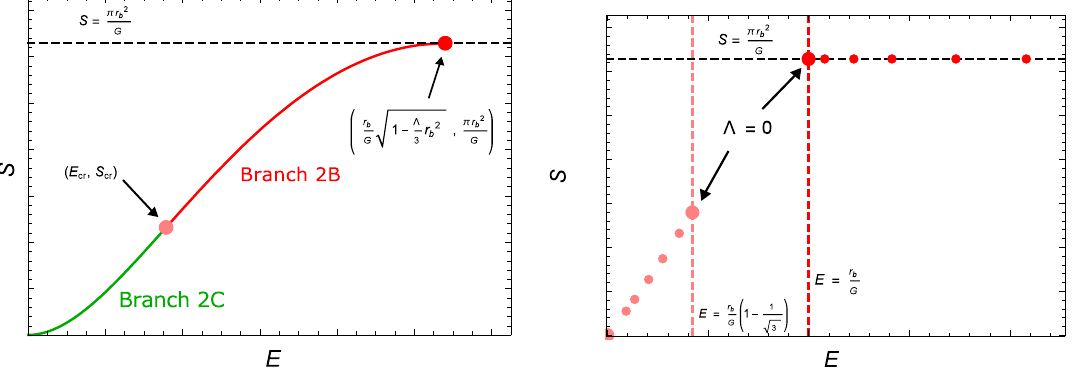
Figure 4 . ( Left ) Qualitative behavior of entropy as a function of energy. The critical point and the maximum entropy point are marked. The energy and entropy at the critical point are given by 2 (see the main text). The maximal energy and entropy are E cr = E cr ( r b , Λ) and S cr = πr H,cr ( r b , Λ) G q 1 − Λ and πr 2 b . ( Right ) Behaviors of critical point and maximum entropy point against Λ on r b r 2 b G 3 G E - S